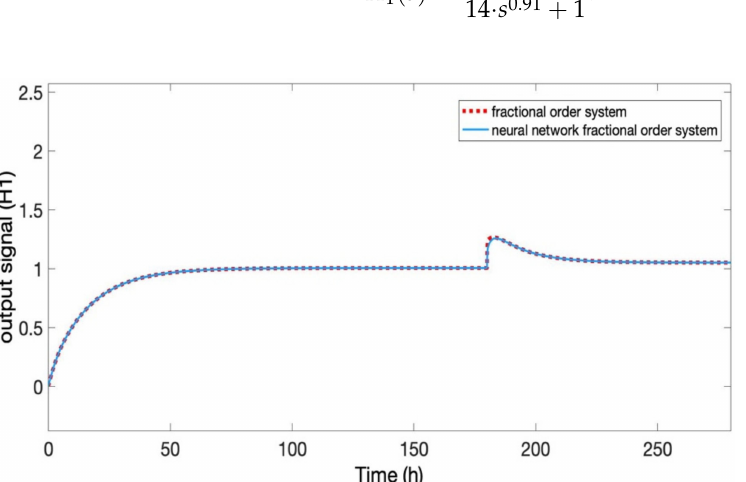
Figure 14. The proof of learning the increasing dynamics of the fractional differentiation order (from β = 0.91 to β = 0.97 at t = 180 ( h )